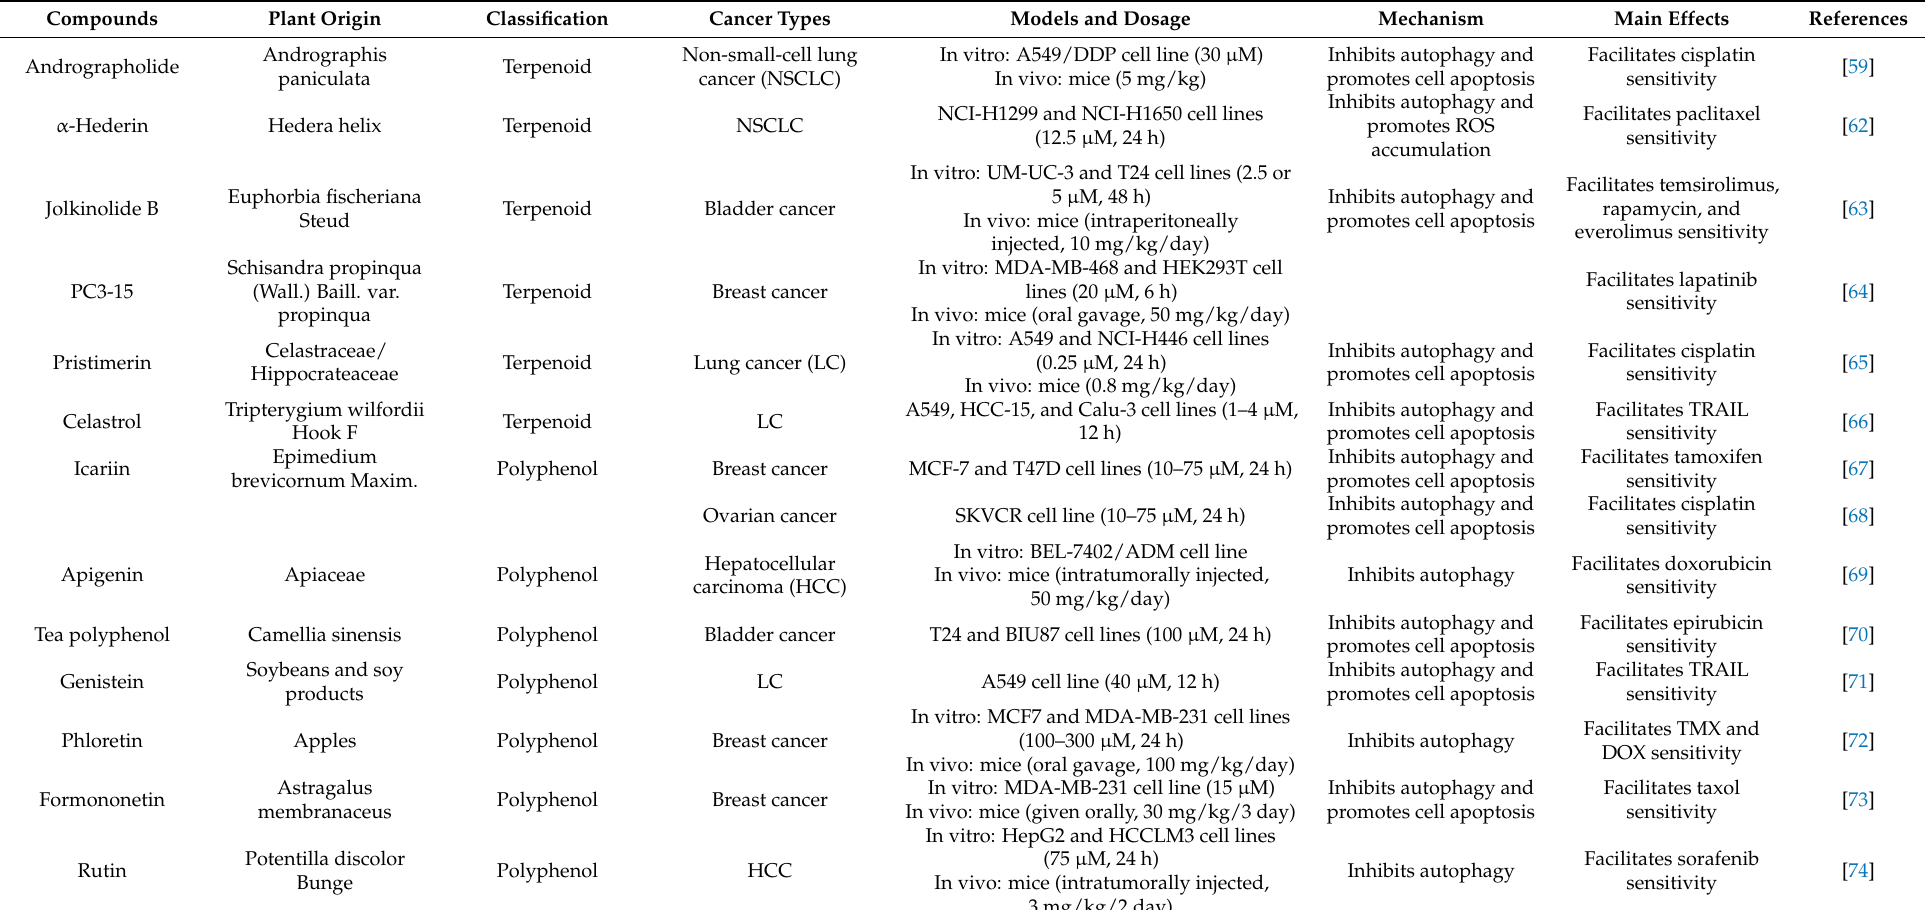
Table 1. Natural products that act against tumor drug resistance by inhibiting pro-survival